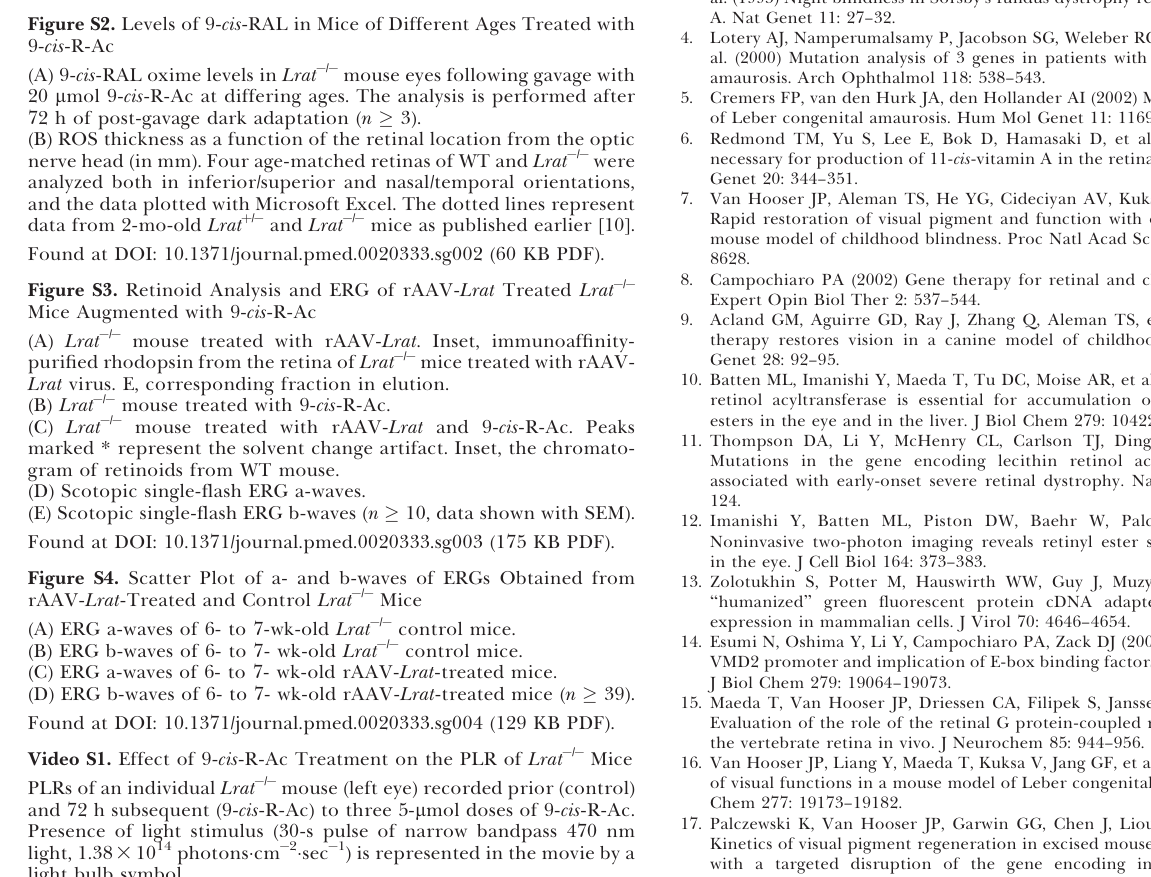
Figure S2. Levels of 9- cis -RAL in Mice of Different Ages Treated with 9- cis -R-Ac (A) 9- cis -RAL oxime levels in Lrat (cid:2) / (cid:2) mouse eyes following gavage with 20 l mol 9- cis -R-Ac at differing ages. The analysis is performed after 72 h of post-gavage dark adaptation ( n (cid:4) 3). (B) ROS thickness as a function of the retinal location from the optic